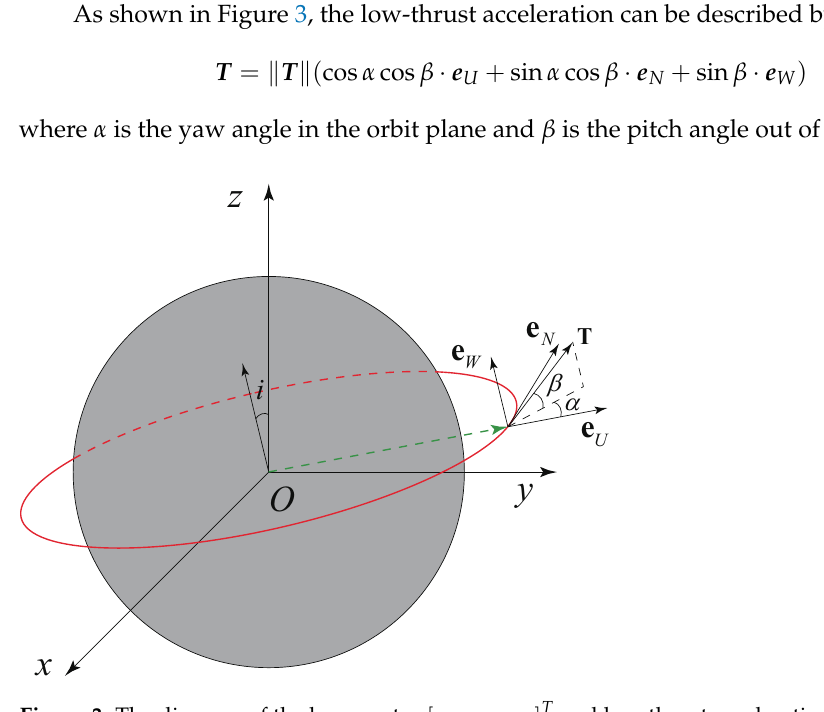
Figure 3. The diagram of the base vector [ e U , e N , e W ] T and low-thrust acceleration T